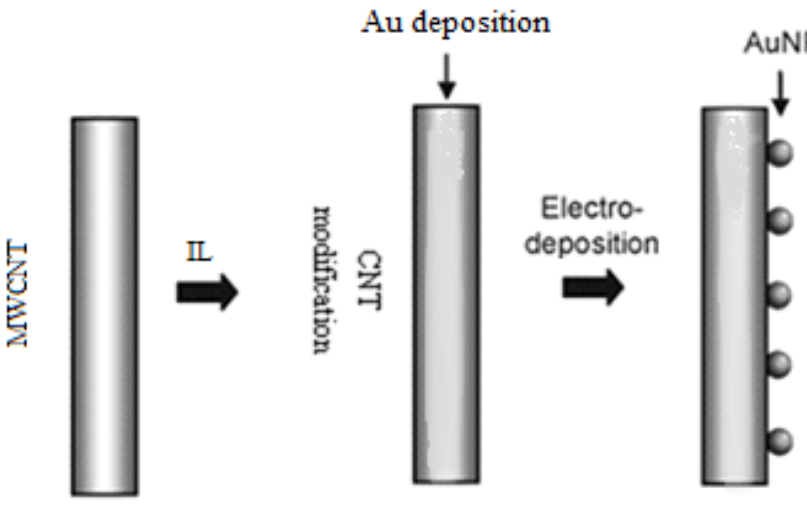
Figure 1. Schematic of MWCNT/Au/IL